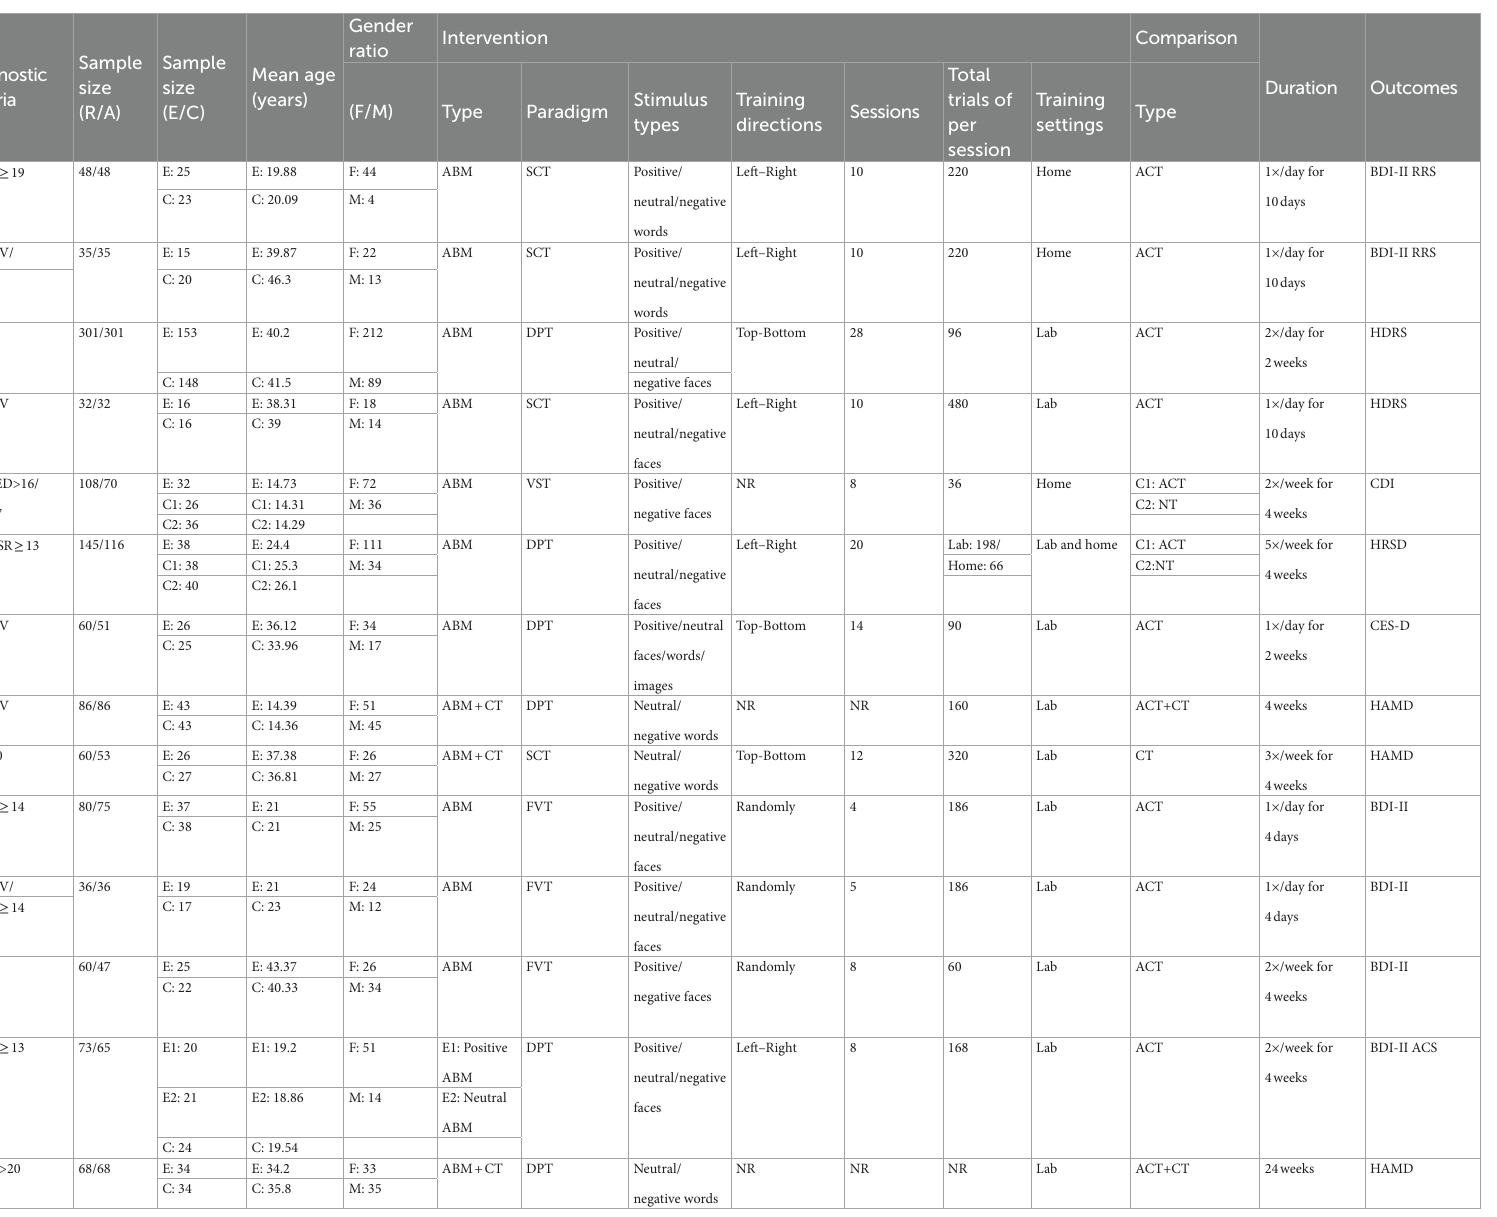
TABLE 1 Characteristics of included